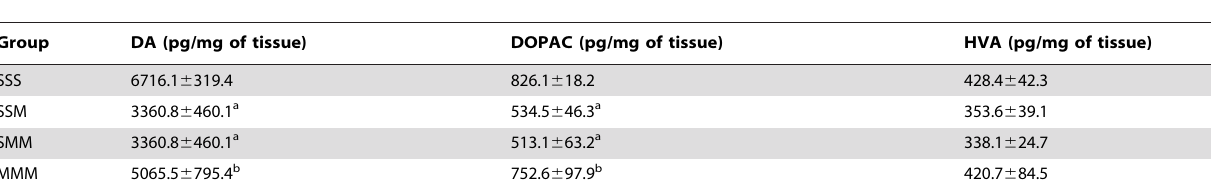
Table 1. Effects of METH preconditioning and challenges on the levels of DA, DOPAC and HVA in the rat striatum.